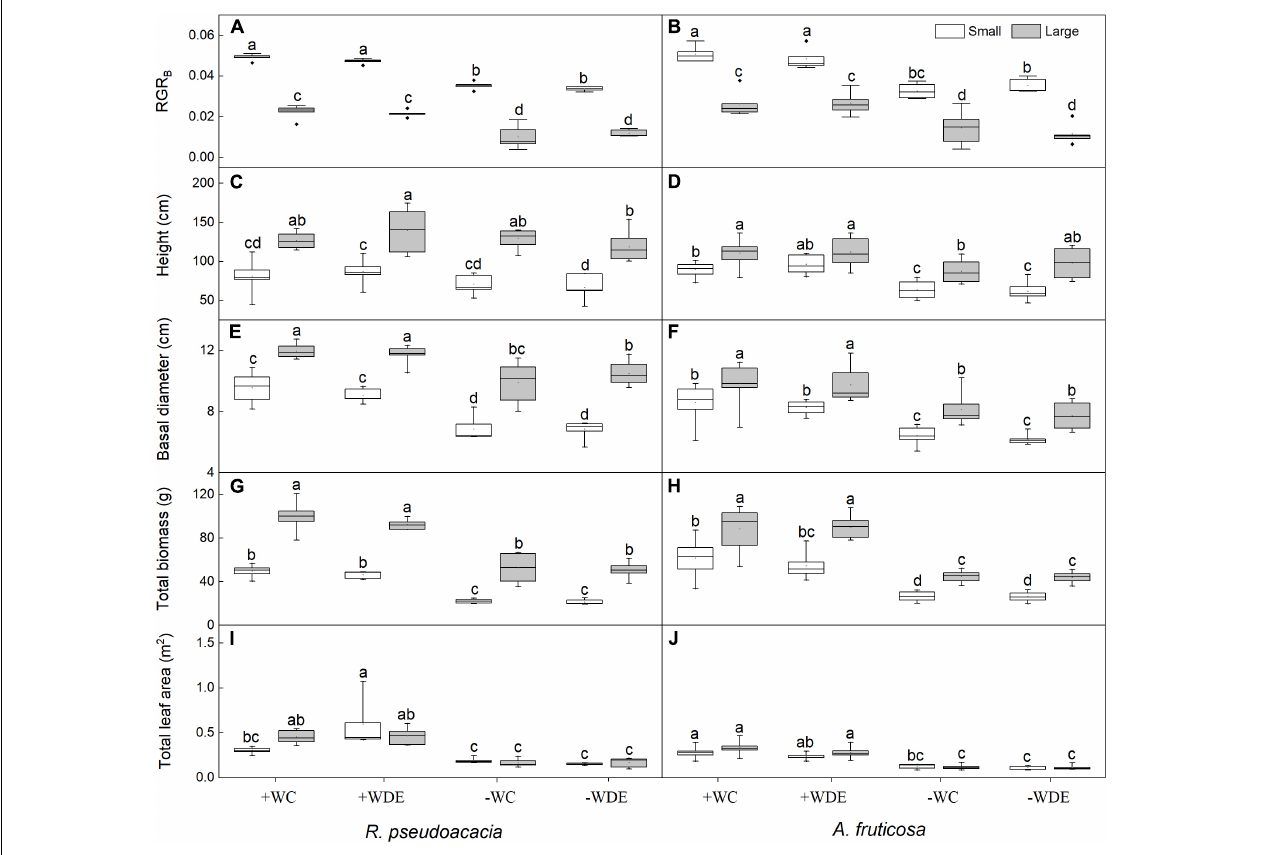
FIGURE 1 | Seedling growth parameters of Robinia pseudoacacia (A,C,E,G,I) and Amorpha fruticosa (B,D,F,H,J) under different water availability and defoliation treatments for 60 days of two plant sizes. The values of the boxplot are the mean of 5–8 replicates. Different letters indicate significant differences among different defoliation treatments according to Duncan’s test ( p < 0.05). +WC, high water availability without defoliation; +WDE, high water availability treatment with defoliation; –WC, low water availability without defoliation; –WDE, low water availability with defoliation; RGR B , relative growth rate of total